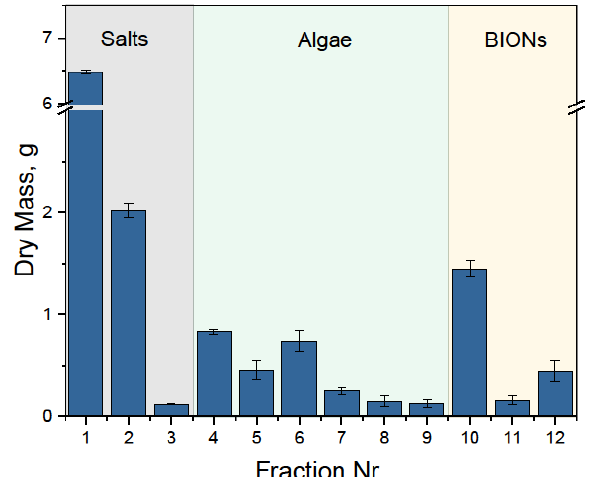
Figure 8. Dry mass of the fractions of the HGMS process with 5 L microalgae suspension, 0.5 g BION /g microalgae , pH 6.75. The first fraction corresponds to the separation step, where the medium free from BIONs and algae is collected. The other salt fractions correspond to the washing steps. The algae fractions correspond to the recovery steps, in each of which 1.5 L water is pumped through the system and circulated by stirring. The last fractions correspond to the BIONs release from the system.